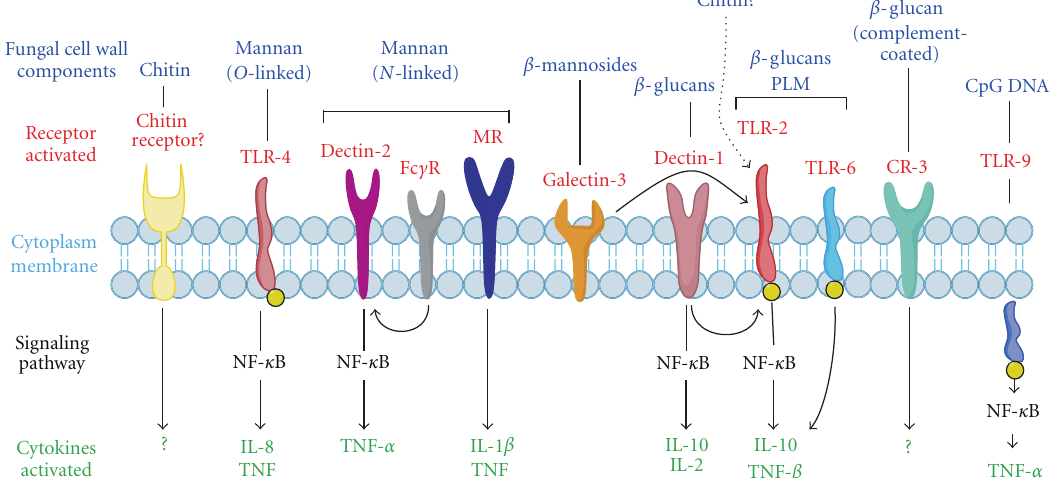
Figure 2: Fungal cell wall pathogen-associated molecular patterns (PAMPs) and their host-pattern recognition receptors (PRRs). Various fungal cell wall components are recognized by specific PRRs. Some PAMPs are recognized by multiple PRRs; for example, N -linked mannan is recognized by mannan receptor (MR), dectin-2, and Fc γ R [46, 47]. Phospholipomannan-(PLM-) coated β -glucans are recognized by both TLR-6 and TLR-2 [53, 54]. Other receptors may involve the signaling pathway of another PRR. For example, galectin-3, which recognizes β -mannosides, signals through TLR-2 (represented by a curved arrow) [47, 49] dectin-1, when activated by β -glucans can signal to activate the nuclear factor kappa-lightchain enhancer of activated B cells (NF- κ B) on its own or with the help of TLR-2 [4, 45]. Fc gamma receptor (Fc γ R) may signal through dectin-2 when activated by N -linked mannan [3, 45, 47, 55]. Recognition of these fungal cell wall components mediates fungal recognition and defense by the host. Recognition by host PRRs usually involves signaling through NF- κ B and activation of proinflammatory cytokines, such as TNF- α , or in some instances, and anti-inflammatory cytokines such as interleukin (IL)-10 [45]. The possibility of an alternative chitin receptor exists, activation of which leads to the recruitment of IL-4 producing cells [45, 59]. However, chitin has been shown to function as a T helper (Th)1 immune modulator, which stands in contrast an IL-4 associated Th2 response [60–64].